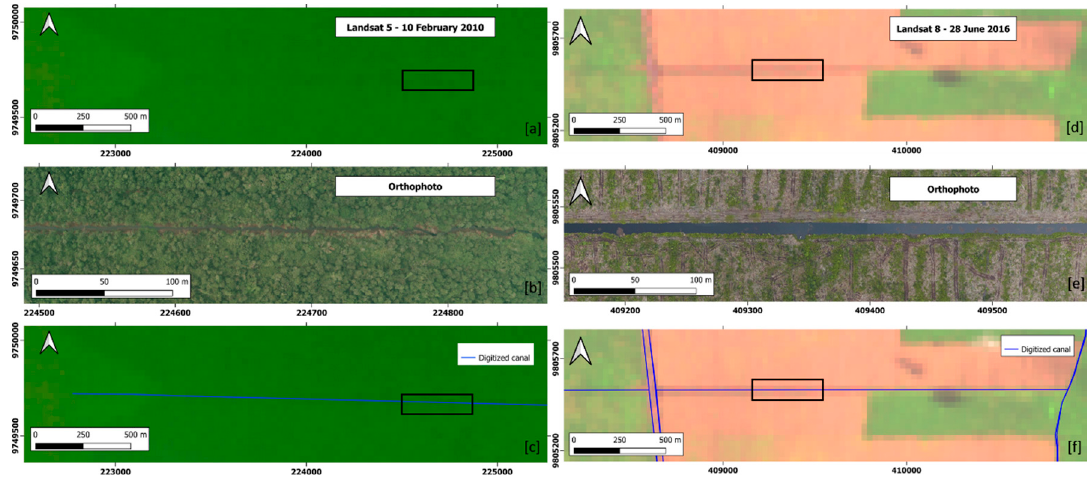
Figure 2. Illustration of canal digitization from Landsat images. ( a – c ) Area in Central Kalimantan where canals are less visible on Landsat, but visible from orthophotos (coordinates in UTM50S) and ( d – f ) plantation area in South Sumatra with canals clearly visible from Landsat images (coordinates in UTM48N).